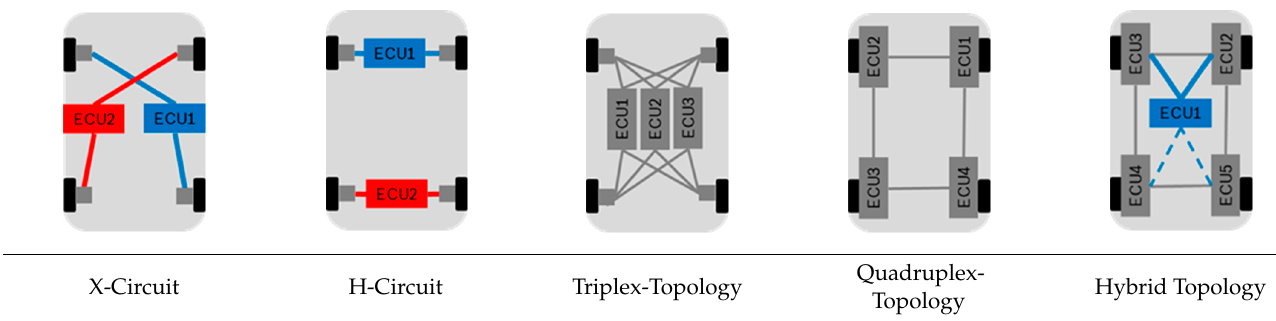
Table 7. Overview of power supply topologies.